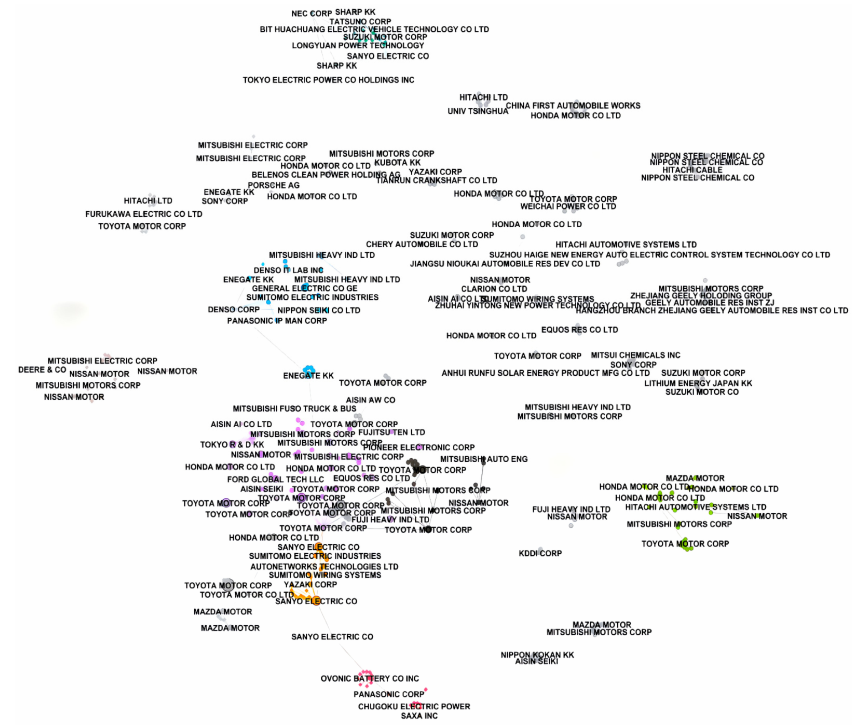
Figure 3. Landscape of community and HITS centrality on patent citation